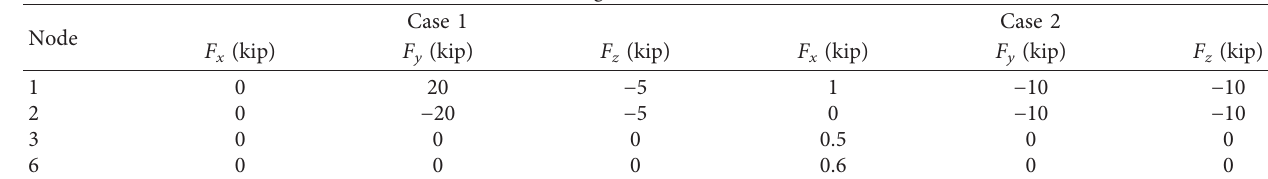
Table 3: The loading condition of the 25-bar truss.